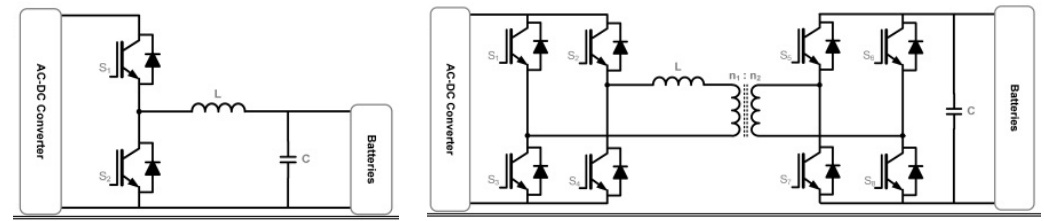
Figure 12. Bi-directional buck–boost converter and bi-directional isolated converter circuits.